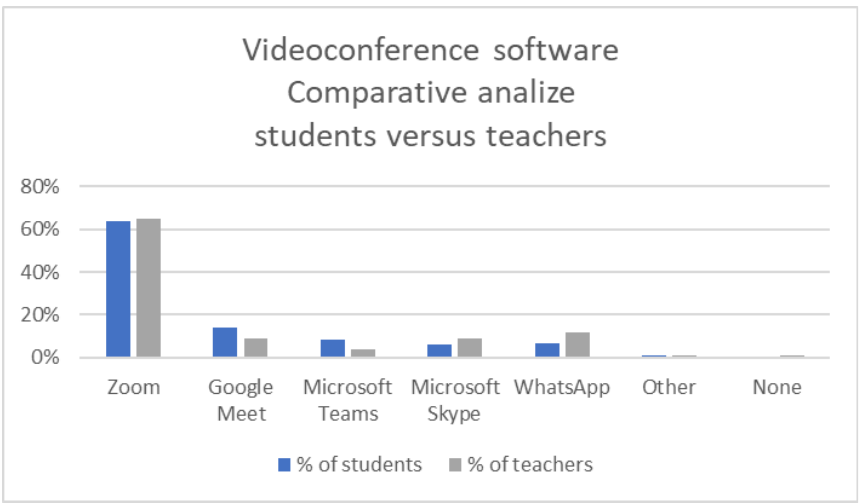
Figure 7. Different perception for meeting tools used, teachers versus students.